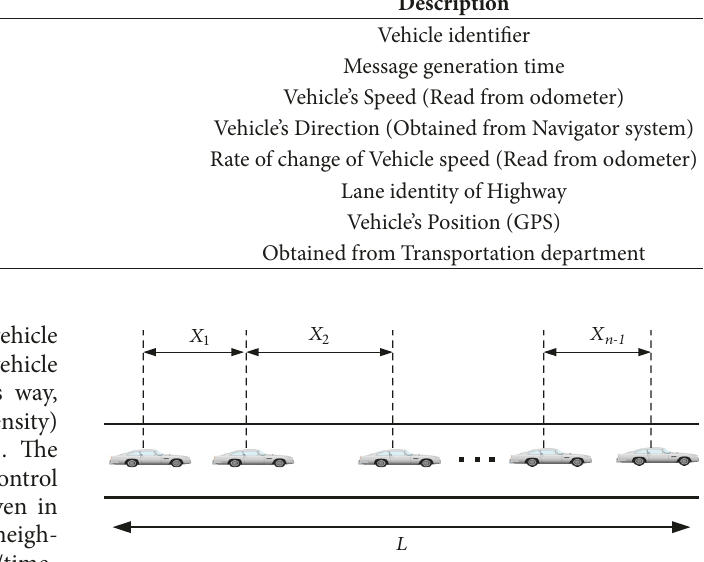
Figure 2: An illustrative scenario where the vehicles are randomly distributed along the